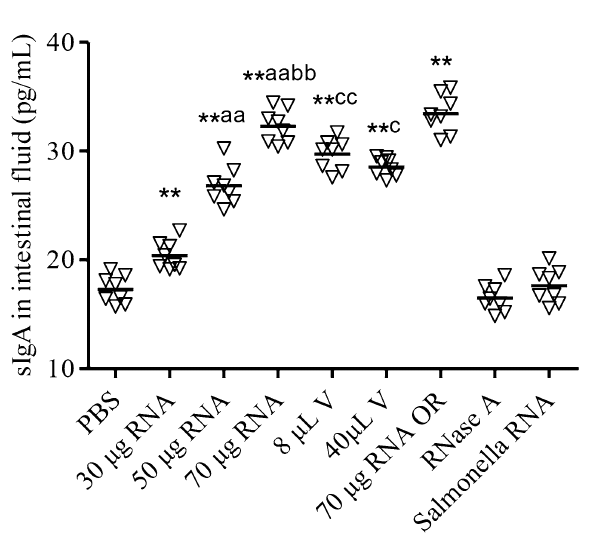
Figure 4. ETEC K88ac specific sIgA levels in the intestinal fluid of the administrated mice. The eight experimental groups of mice (n = 8) were intramuscularly injected with PBS, ETEC total RNA (30 μg RNA; 50 μg RNA; 70 μg RNA), ETEC vaccine (8 μL V; 40 μL V), RNase A treated ETEC RNA (labeled as RNase A) and 70 μg Salmonella RNA in a total volume of 100 μL. The ninth group of mice (n = 8) was orally